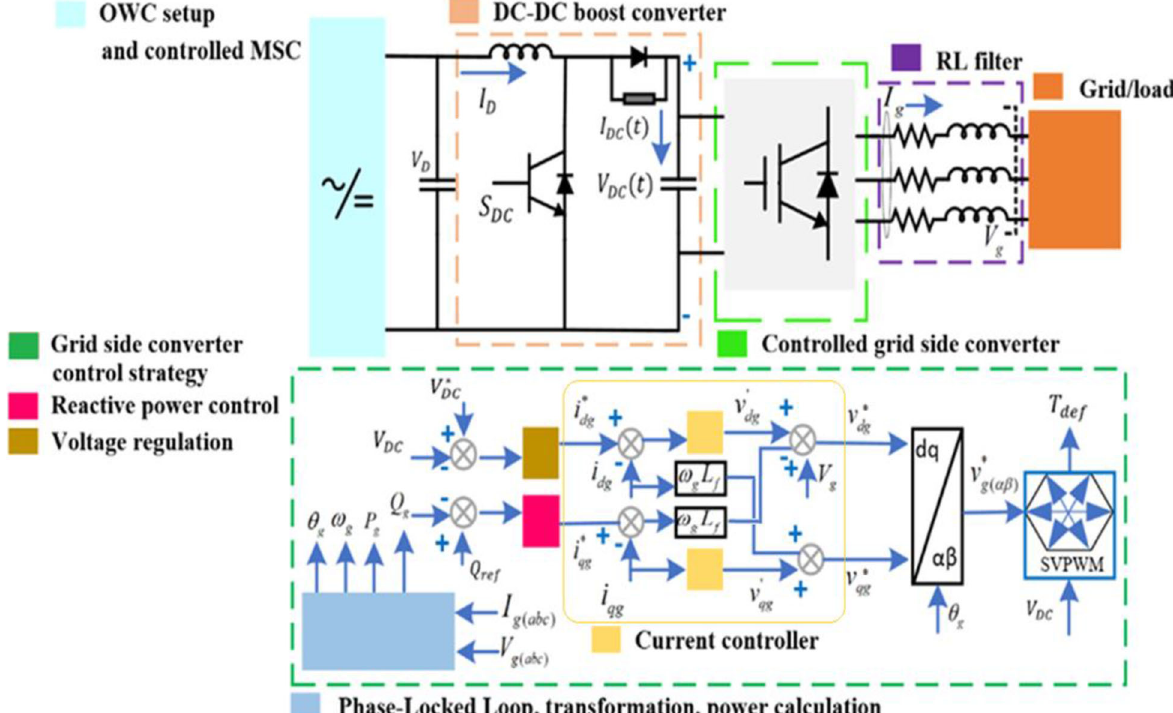
Fig. 6 Schematic of GSC control